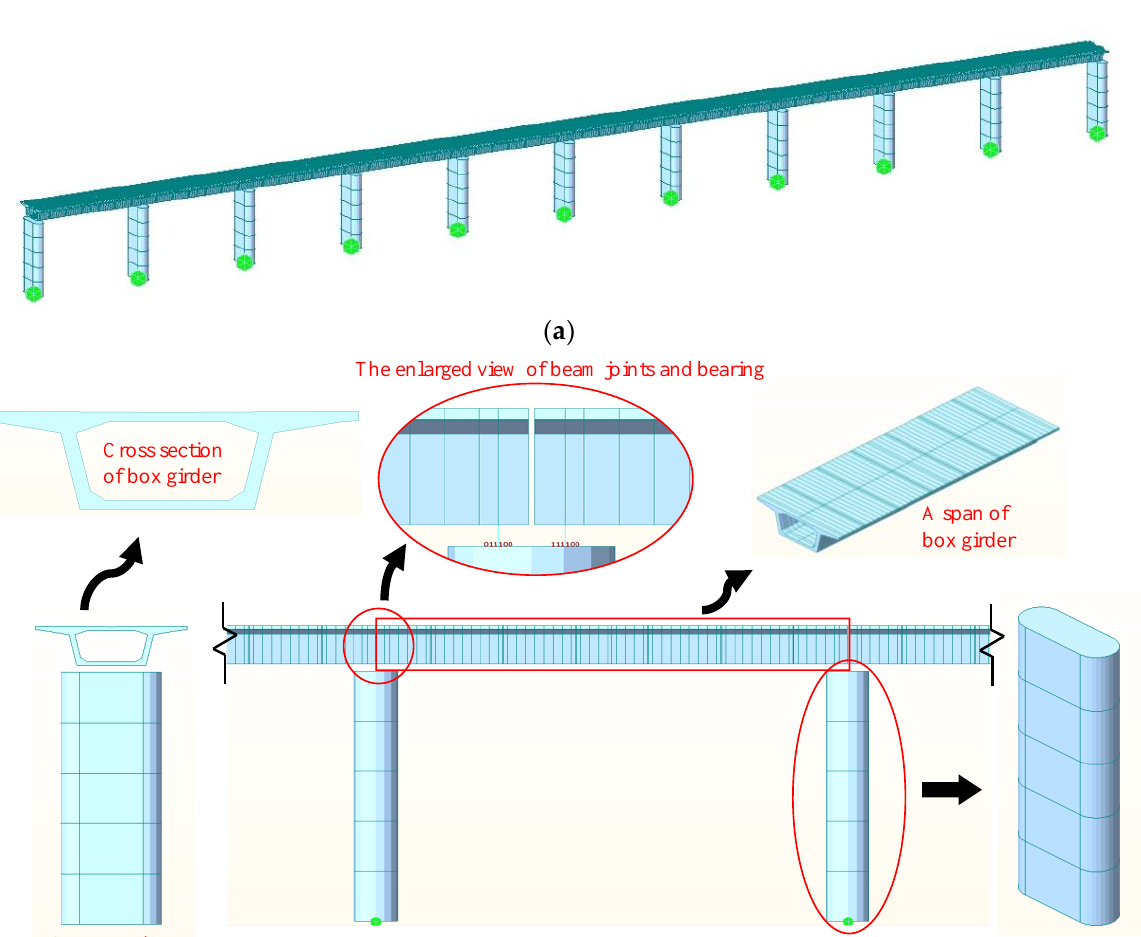
Figure 11. Three-dimensional finite element model of rail–track–bridge. ( a ) Three-dimensional finite element model of rail–track–bridge with 10-span box girders. ( b ) The enlarged view of box girder and